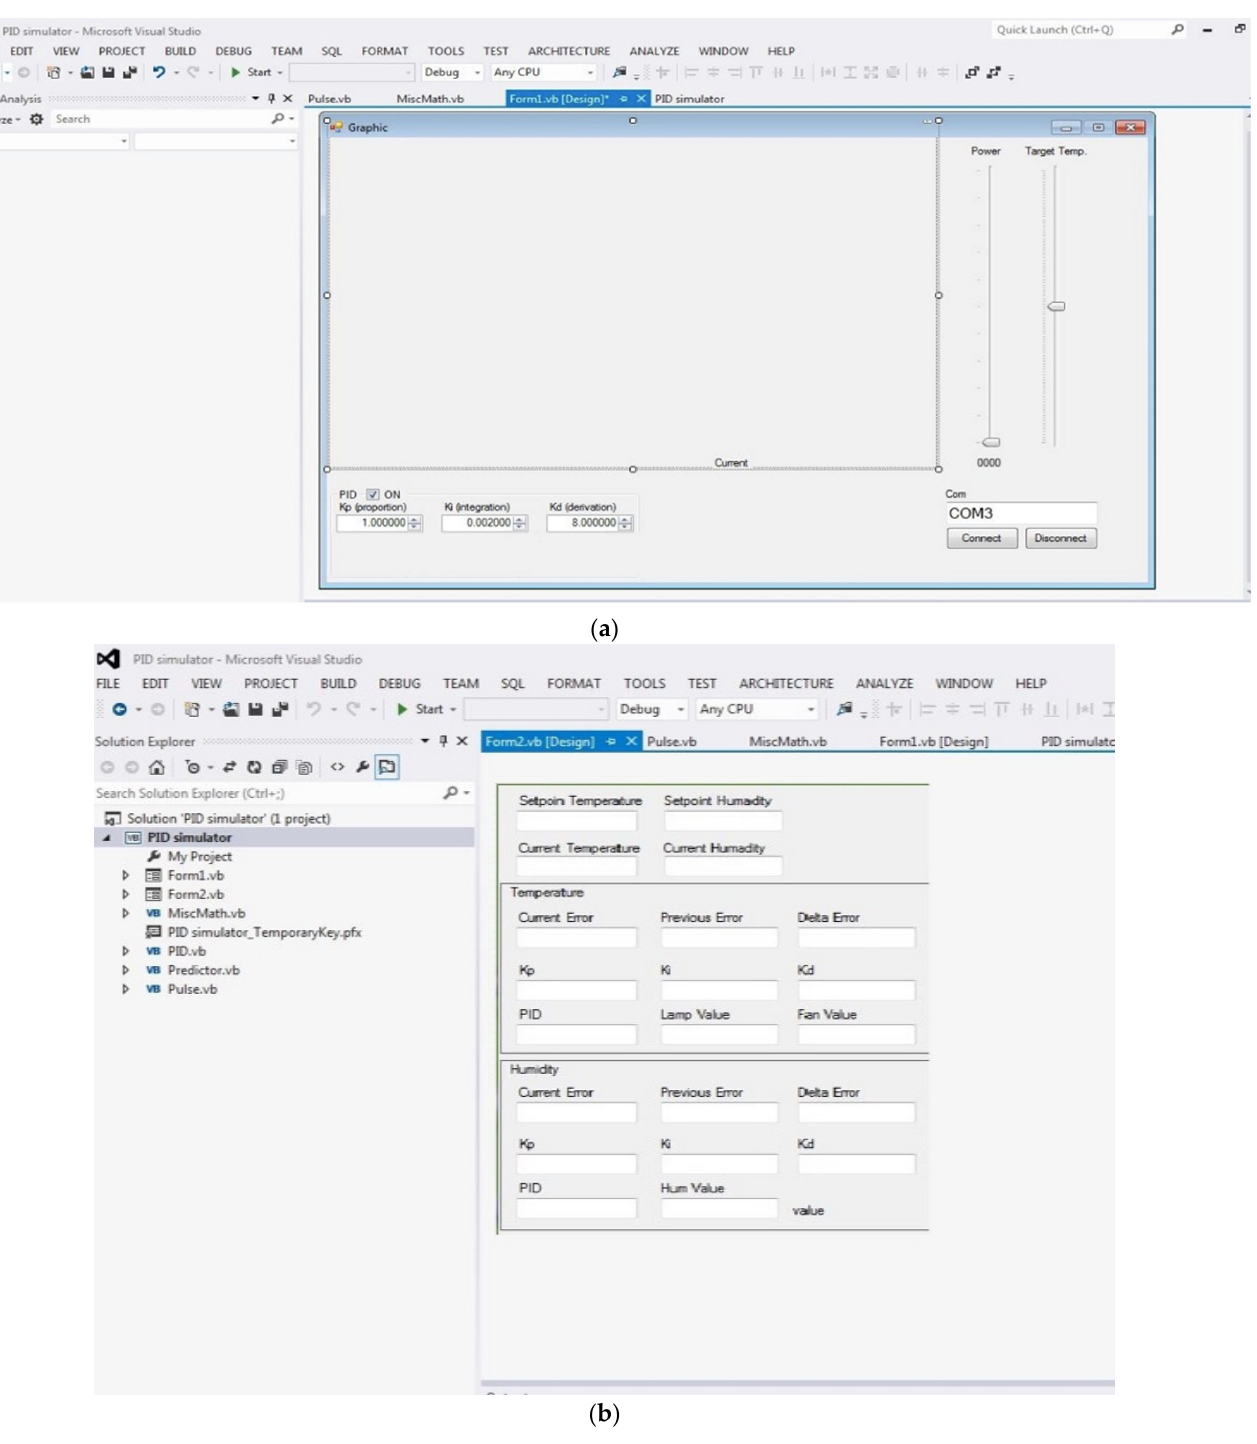
Figure 5. ( a ) Visual Basic.Net Work Window Display ( b ) Value form display.